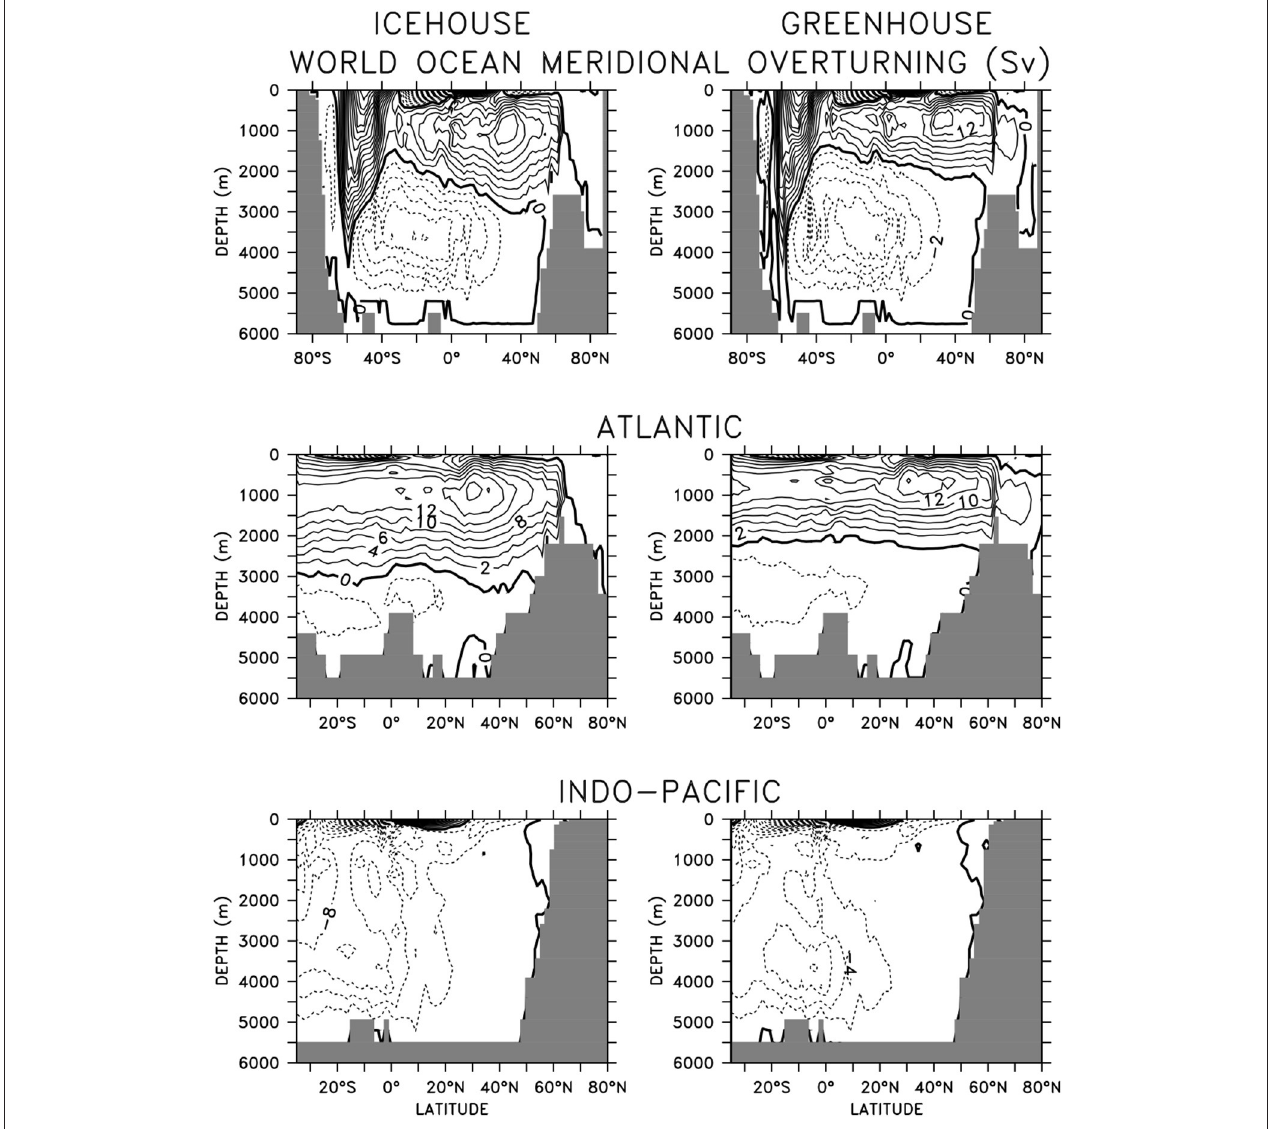
FIGURE 1 | Basin-averaged meridional overturning in equilibrated (20,000 year integration) icehouse (left column) and greenhouse (right column) climates. Contours denote 2 Sv